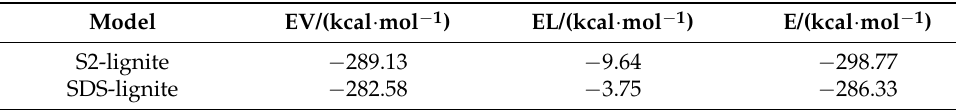
Table 1. Interaction energy between surfactant and